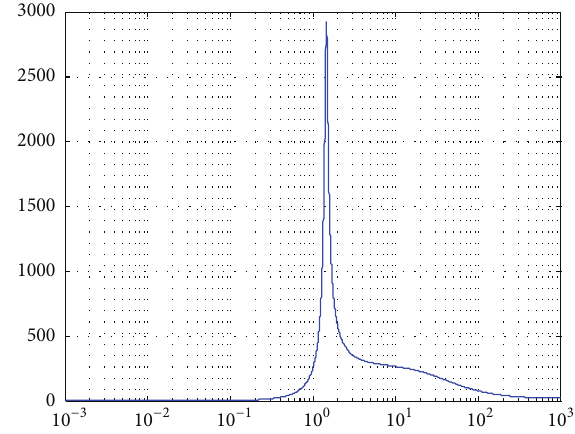
Figure 12: Condition number 𝜅 3 (𝑗𝜔) (Case 3